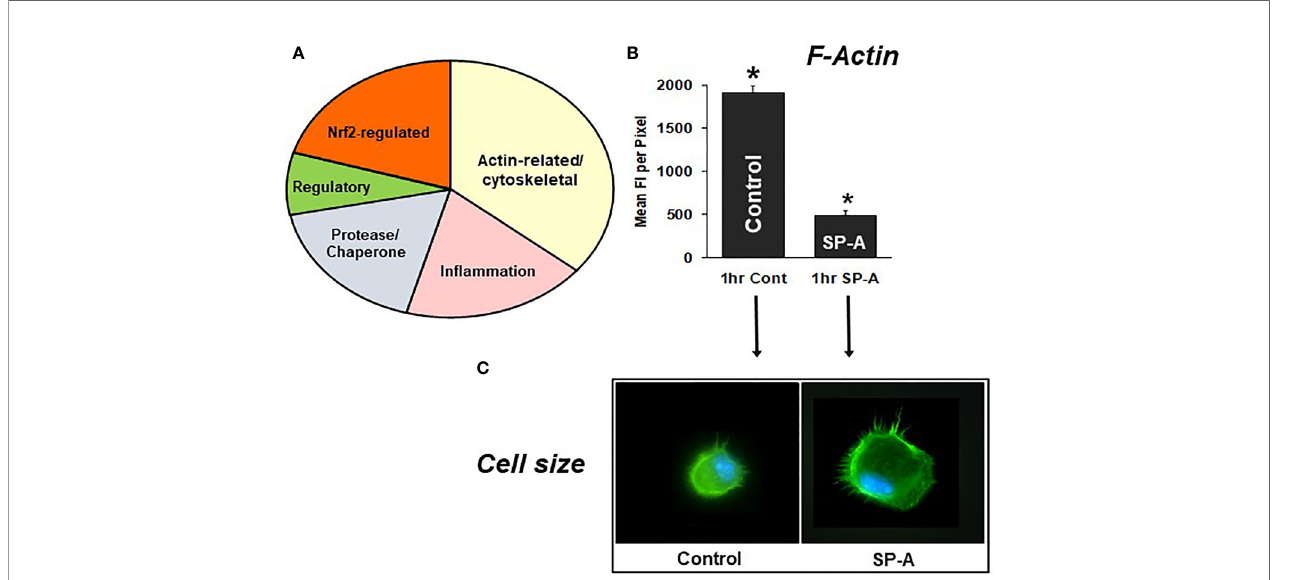
FIGURE 7 | SP-A rescue of the SP-A KO AM. (A) depicts the groups of proteins that changed in response to SP-A. (B) depicts the mean fl uorescence per pixel of F-actin (cells stained with Alexa Fluor 488 phalloidin) after 1hr of treatment with SP-A (1hr SP-A) or untreated (1hr control) SP-A KO AM (105). (C) depicts the actual fl uorescence in the control and SP-A-treated AM as well as the size change after the treatment (110). AMs were visualized using a Nikon TE-2000 PFS fl uorescent microscope with a 60X (1.4 NA) phase contrast lens with a 1.5× tube lens in place and the images captured using a Photometrics Coolsnap HQ2 digital camera (0.07 m m/pixel) and saved as TIFF fi les (105). *p <